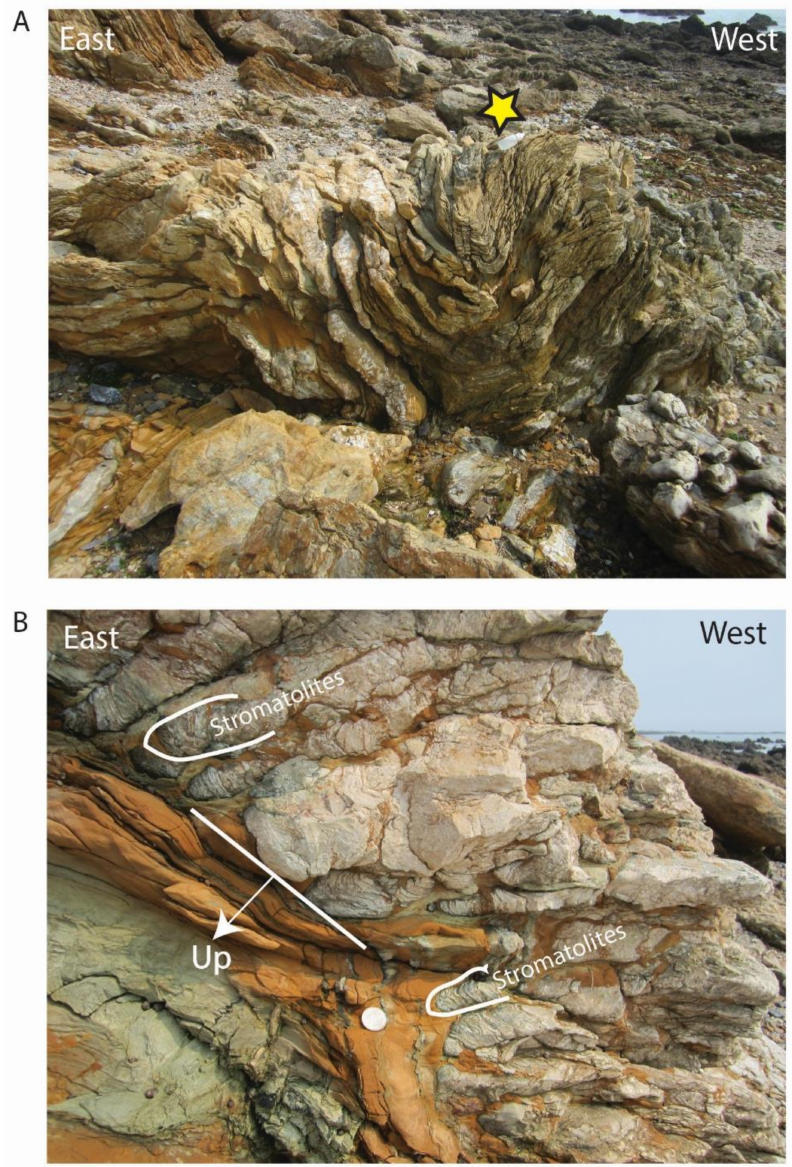
Figure 2. The minor fold with synfolding calcite and horizontal, grooved synfolding calcite ( A ; acid bottle by star for scale) is found along the shoreline in proximity to overturned Proterozoic stromatolites ( B ; coin for